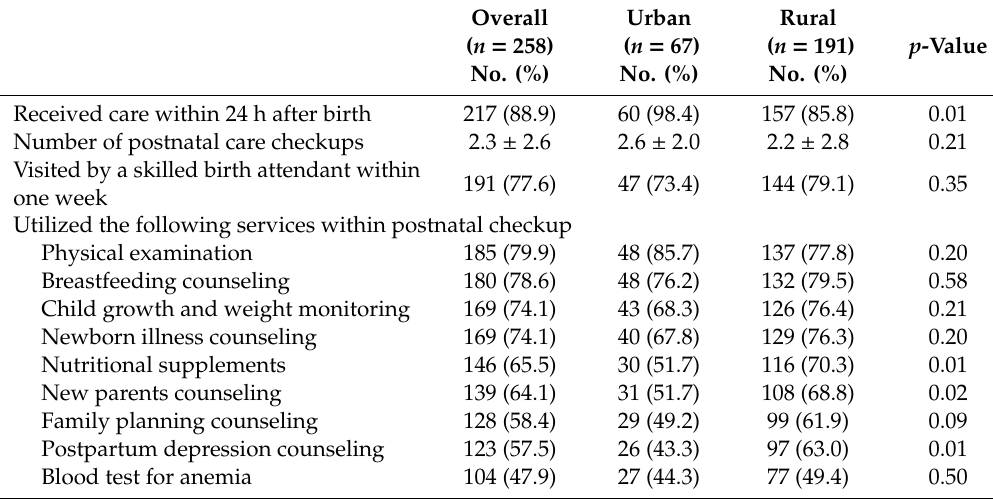
Table 5. Utilization of postnatal care services.